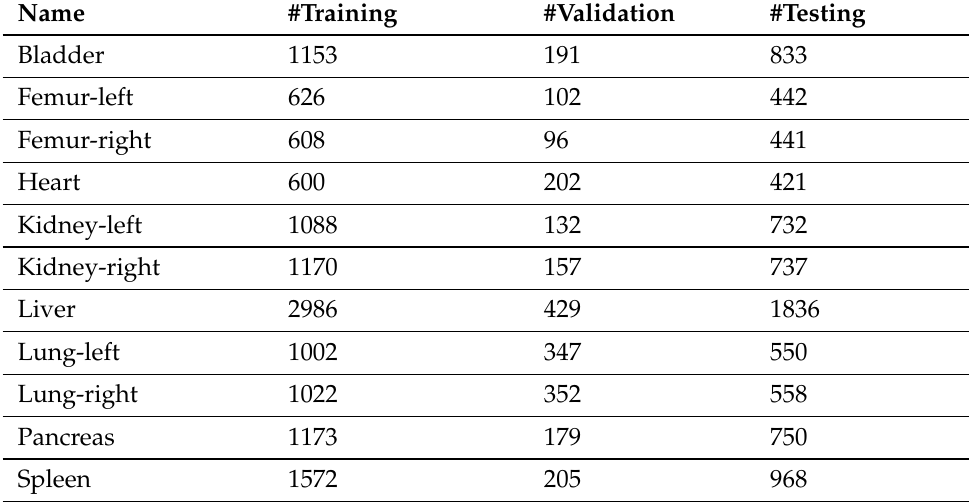
Table 7. Details of OrganMNIST_Coronal